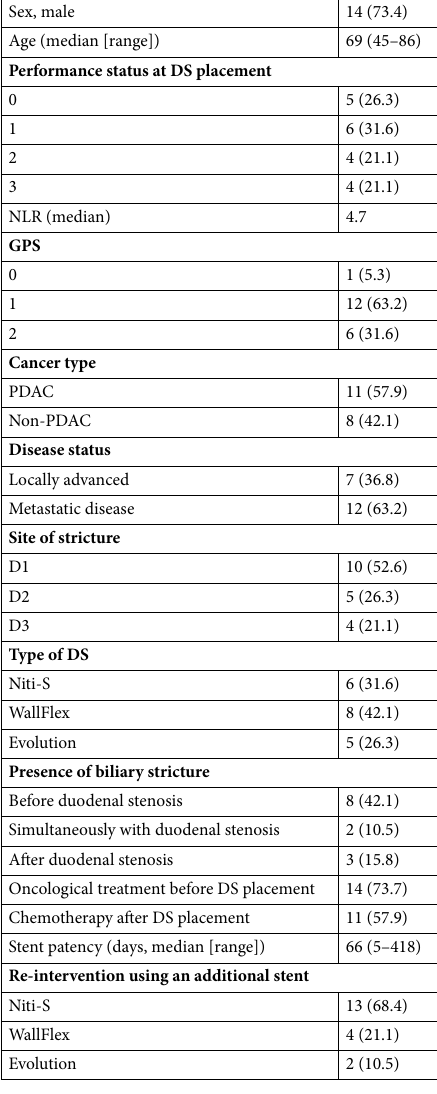
Table 4. Characteristics of 19 patients with duodenal stent occlusion. Categorical data are presented as number (percent), continuous data as median (range). DS duodenal stent, GPS Glasgow Prognostic Score,